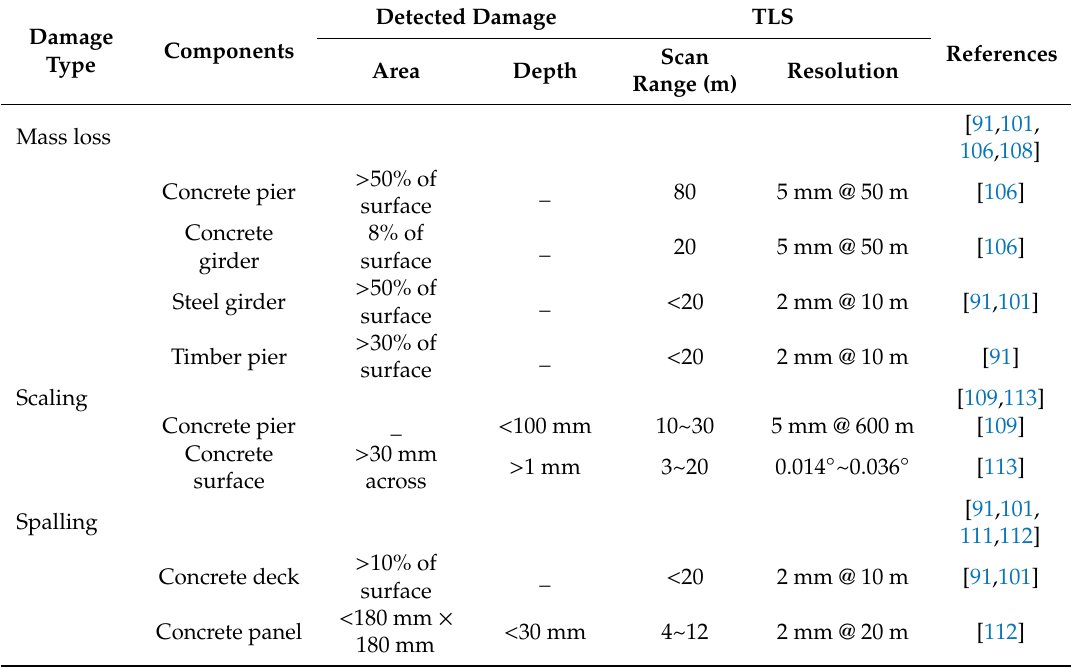
Table 6. Examples of mass loss, scaling and spalling in di ff erent